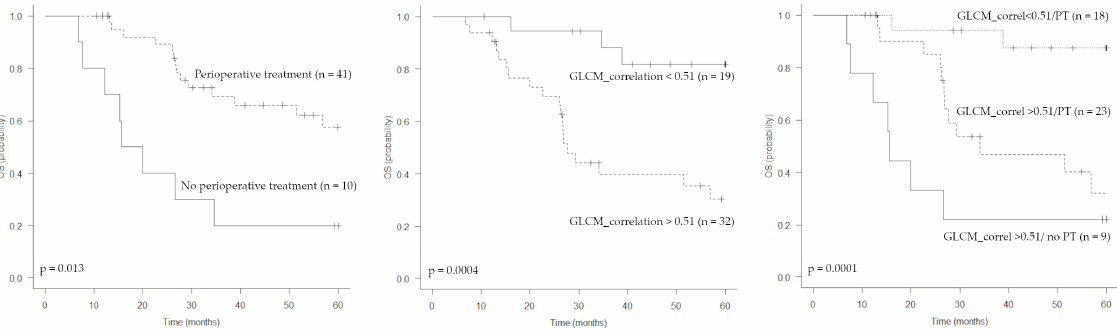
Figure 4. Kaplan–Meier estimations of overall survival (OS) according to perioperative treatment, GLCM_correlation and both parameters combined. GLCM_correlation and both parameters